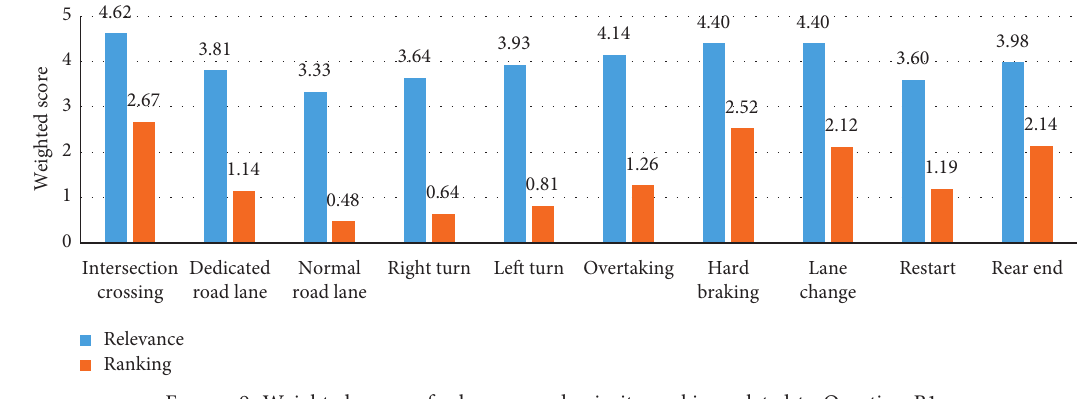
Figure 9: Weighted mean of relevance and priority ranking related to Question B1.